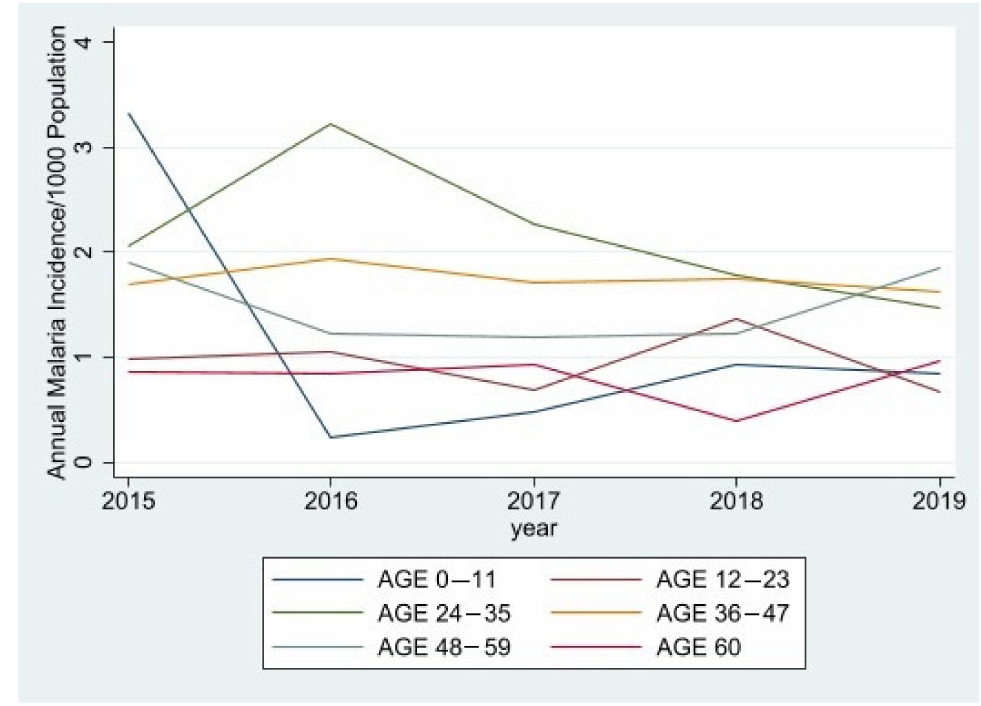
Figure 3. Annual incidence of Malaria for Age groups 0–5 years from 2015 to